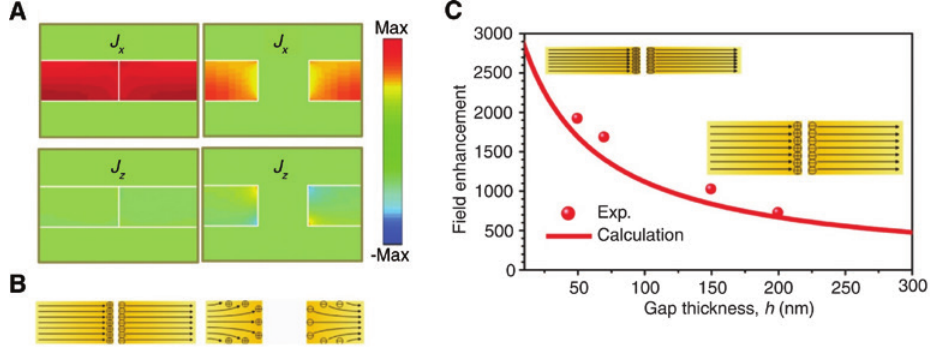
Figure 7: w / h -dependent field enhancement. (A) Numerically calculated maps of induced current J in thin gold films. Here, h = 150 nm and w = 1.5 nm (left) and 200 nm (right). 0.3 THz incident light is considered. (B) Schematics of induced current and accumulated charges for narrow ( w = h ) and wide ( w ~ h ) gaps. (C) Experimentally measured and analytically calculated FE of 0.3 THz field in a 5 nm gap with varying thickness h . Inset figures illustrate higher surface charge density in a thinner gap, while total accumulated charge is independent of the thickness. Note that FE is modified from Eq. (1) due to the substrate effect. This figure is reproduced from Ref.